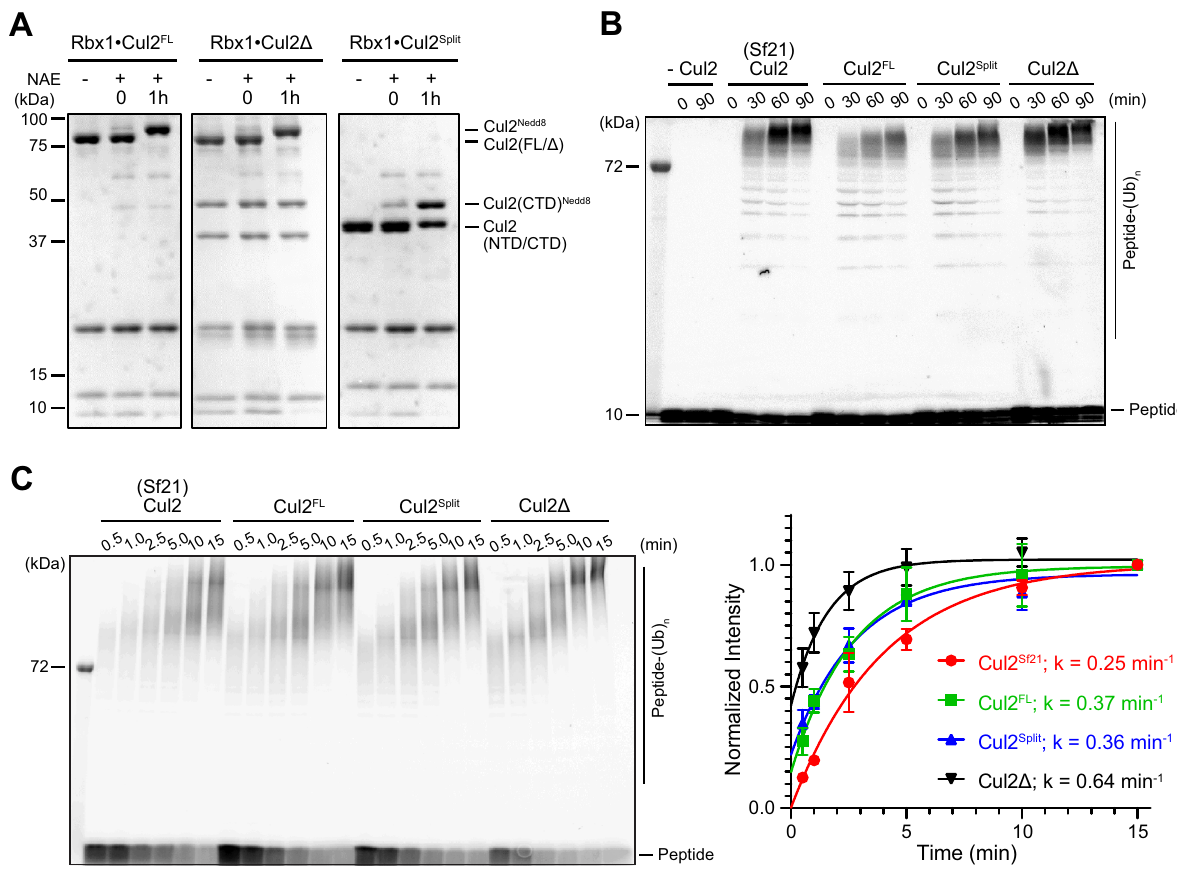
Figure 4. The enzyme activity of the recombinant RBX1•CUL2 proteins. ( A ) The purified CUL2 FL , CUL2Δ, and CUL2 Split can be efficiently neddylated. Protein samples with indicated reaction conditions were fractionated on SDS-PAGE and stained with Coomassie Blue. ( B ) The purified RBX1•CUL1 FL , RBX1•CUL2Δ, and RBX1•CUL2 Split can efficiently ubiquitinate a peptide substrate derived from the degron motif of HIF1α. The peptide substrate contains a TAMRA fluorescent dye. Recombinant RBX1•CUL2 produced from insect cells (Sf21) was included as a positive control, whereas samples with no CUL2 were included as a negative control. Protein samples with indicated reaction conditions were fractionated on a 16% SDS-PAGE gel and scanned for TAMRA signal to detect the unmodified and ubiquitinated peptide substrate. ( C ) Quantitative comparison of CRL2 VHL ubiquitination activities. The same assay as in ( B ) was performed with indicated time points, and samples were fractionated on 4–20% SDS-PAGE gels. TAMRA signal intensities of ubiquitinated substrates were quantified, normalized to signals of the last sample points, and averaged. Single exponential fits with the normalized intensities were shown in the plot on the right, together with k values from the regression for each RBX1•CUL2 variant. Error bar: standard error (n =